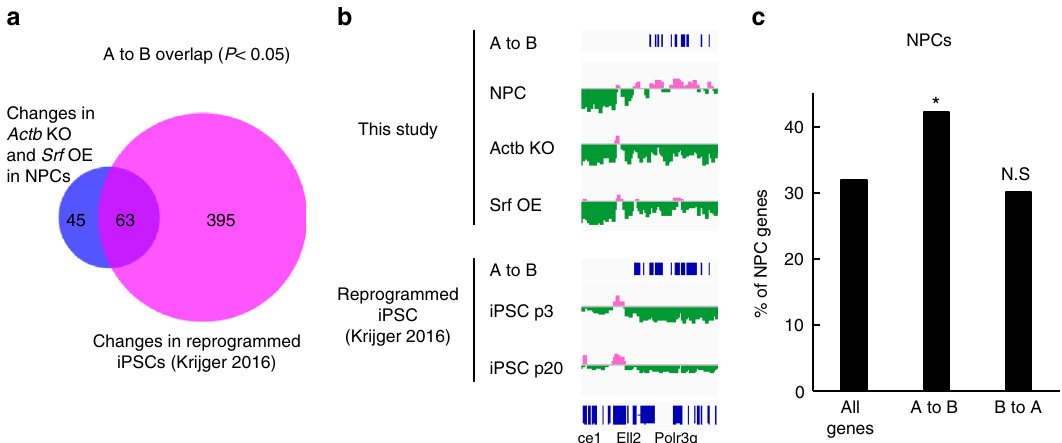
Fig. 5 β -Actin-Srf pathway induces a global reorganization of the subnuclear compartment. a Activation of the β -actin-Srf pathway alone induces a global reorganization of the subnuclear compartment that resembles partial reprogramming. Venn diagram of the chromatin-organization changes from compartment A to compartment B in NPCs. Peak numbers are shown. b A region on chromosome 13 where the patterns from A to B are similar in Actb knockout, Srf overexpression in NPCs, and reprogramming to iPSCs. c Cell-type-speci fi c genes are enriched in genes that change their subnuclear compartment from A to B by the β -actin-Srf pathway. Asterisks and N.S. indicate a signi fi cant difference and no signi fi cant difference, respectively, between genes in the indicated group and all other genes (two-sided Fisher ’ s exact test; * P <